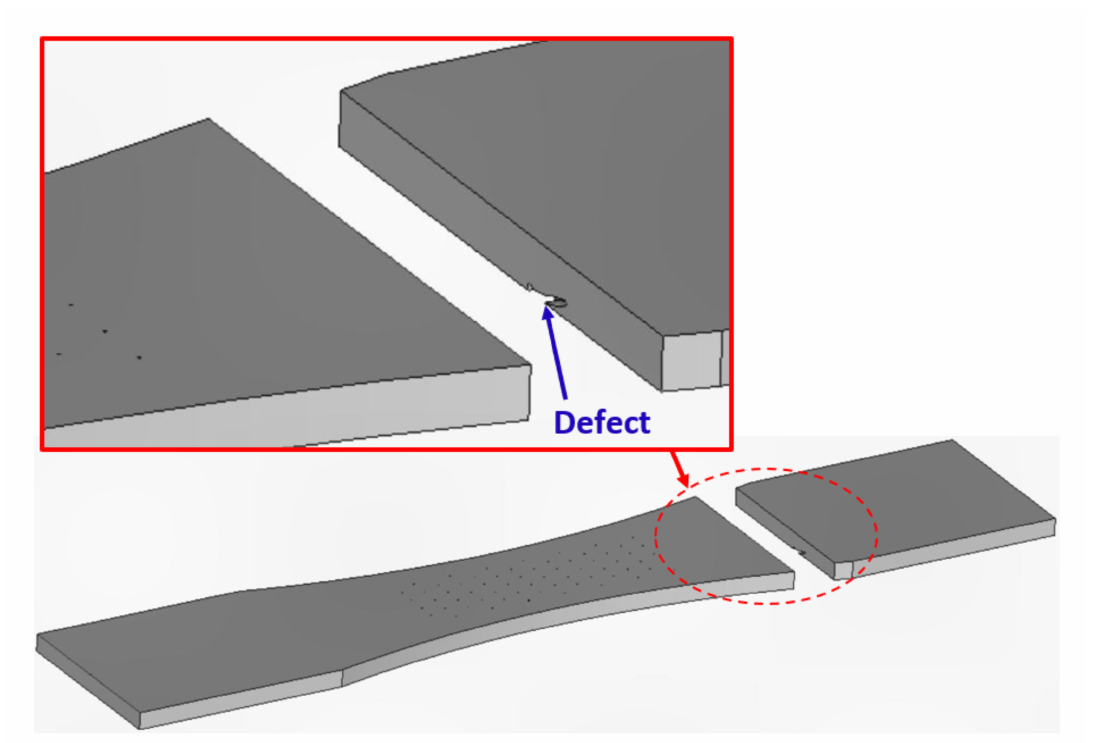
Figure 7. The CAD